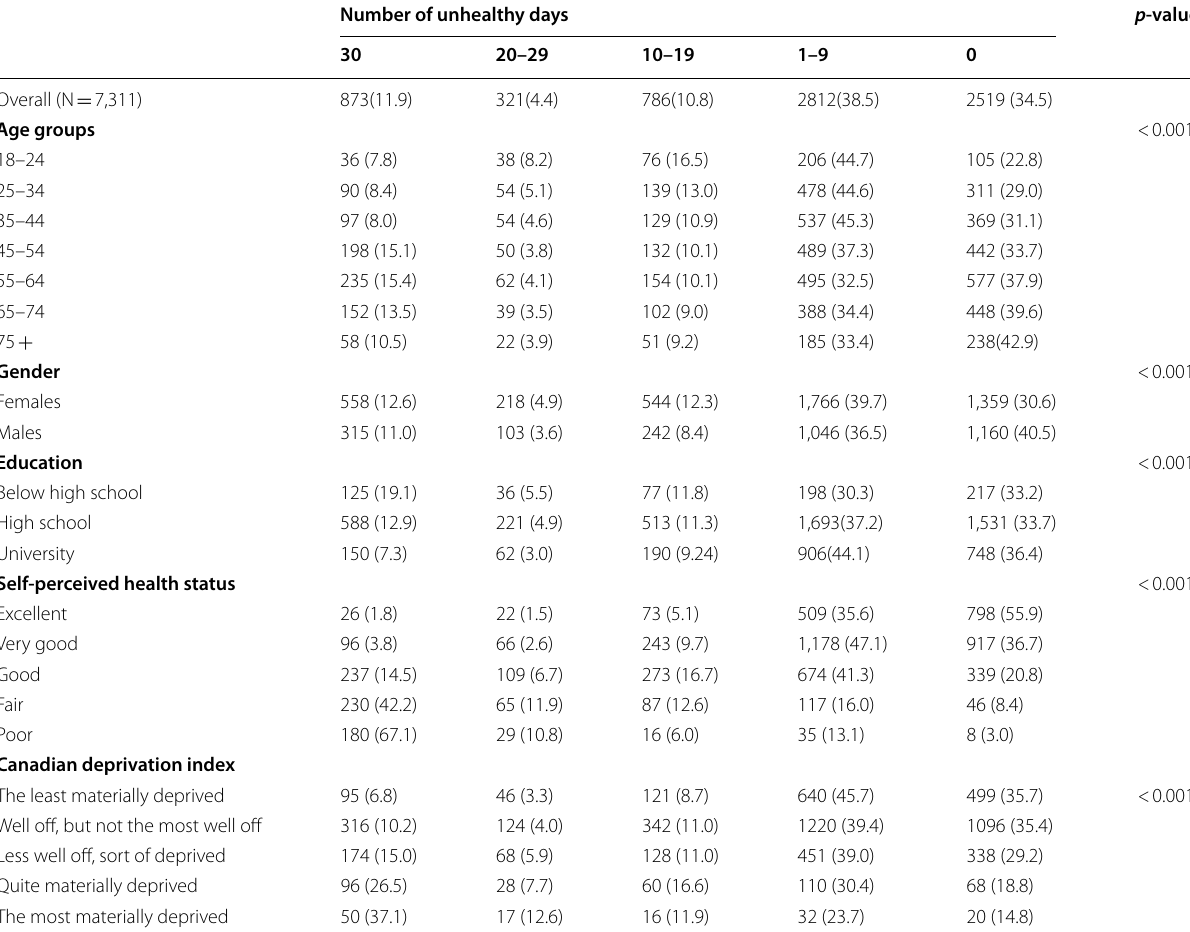
Table 3 General characteristics of participants by number of unhealthy